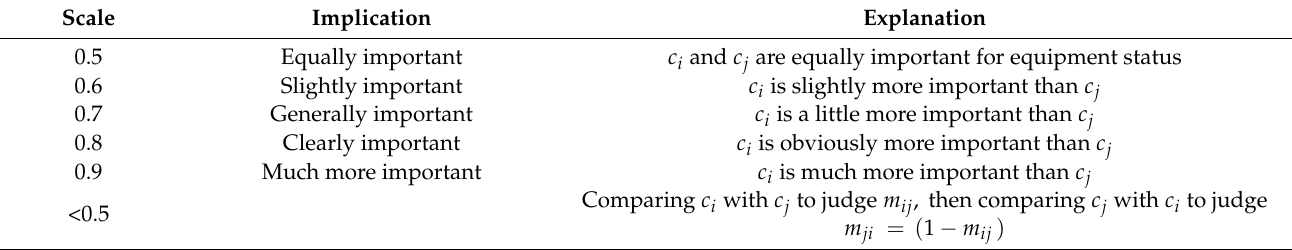
Table 4. Scale meaning and explanation in matrix M .